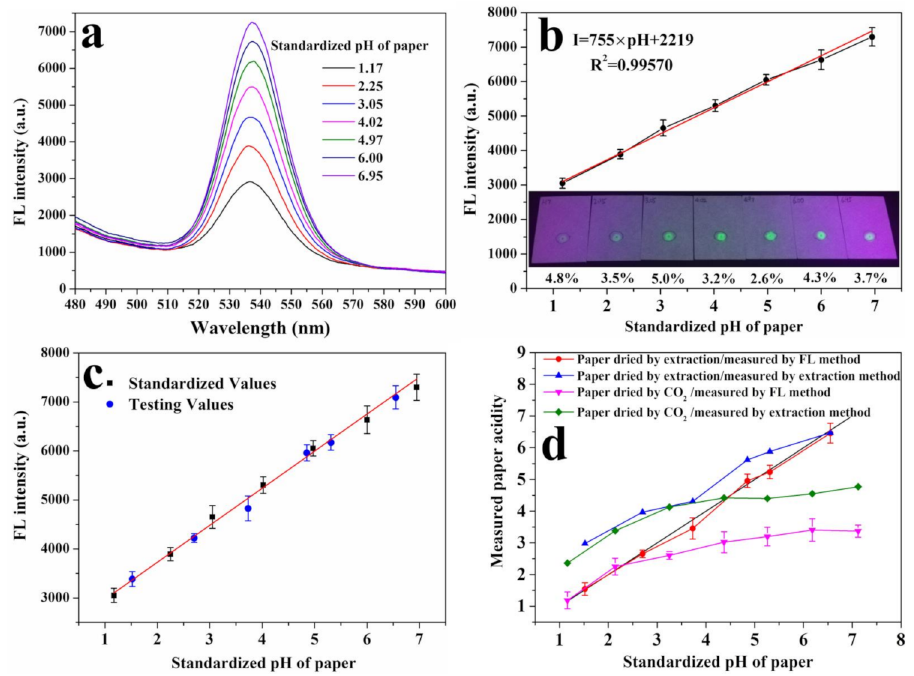
Figure 6. ( a ) The fluorescence spectra of CdZnSeS-pATP QDs on the paper with different standard- ized pH values. ( b ) The linear dependency between the fluorescence intensity at maximum emission 537 nm and pH. The error bars represent the standard deviation of four measurements. The RSD of four measurements were marked at each pH. Inset shows the fluorescence photographs of the paper with different standardized pH values. The circles marked on the paper indicate the area of the light spot of fluorescence measurement. The red line represents the fitting curve of measured values. ( c ) The plot of fluorescence intensity of testing values at the maximum emission wavelength 537 nm as a function of pH. The error bars represent the standard deviations of four measurements. ( d ) The measured acidity of the paper with different standardized pH values as determined by different methods. The error bars represent the standard deviations of four measurements. ( λ ex = 365